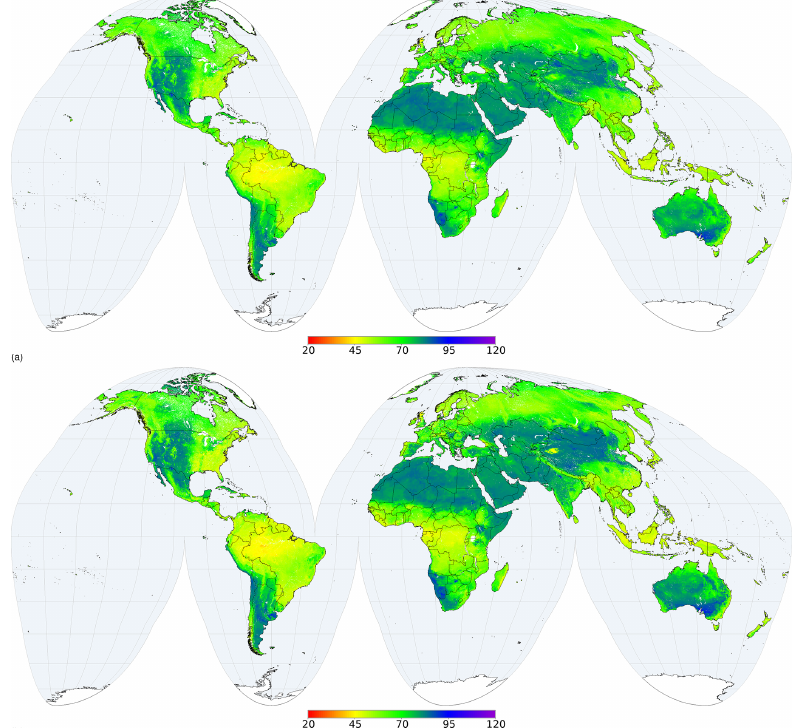
Figure 10. Prediction distribution for pH water (10pH) in the 60 to 100cm depth interval, (a) for 5% quantile and (b) for 95% quantile.